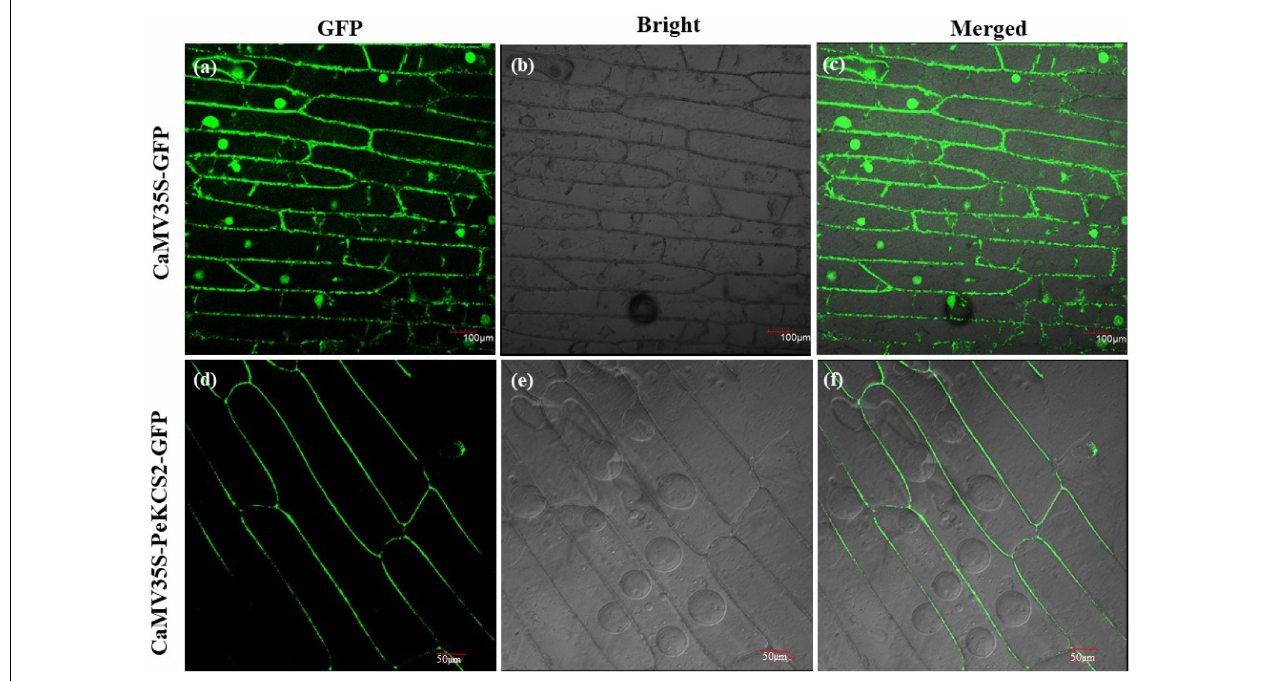
FIGURE 10 | Subcellular localization of GFP-fused PeKCS 2 protein based on transient expression in onion epidermal cells. (a–c) Onion cells transformed with CaMV35S–GFP as control (scale bar = 100 µ m). (d–f) Onion cells transformed with CaMV35S- PeKCS 2-GFP (scale bar = 50 µ m). (b,e) Onion epidermal cells under bright light. (a–d) GFP signal under dark field. (c,f) represent merged of (a,b) , and (d,e) , respectively. The transiently expressed in inner epidermis of onion was observed by laser scanning confocal microscopy (Olympus, Japan) after 24 h.